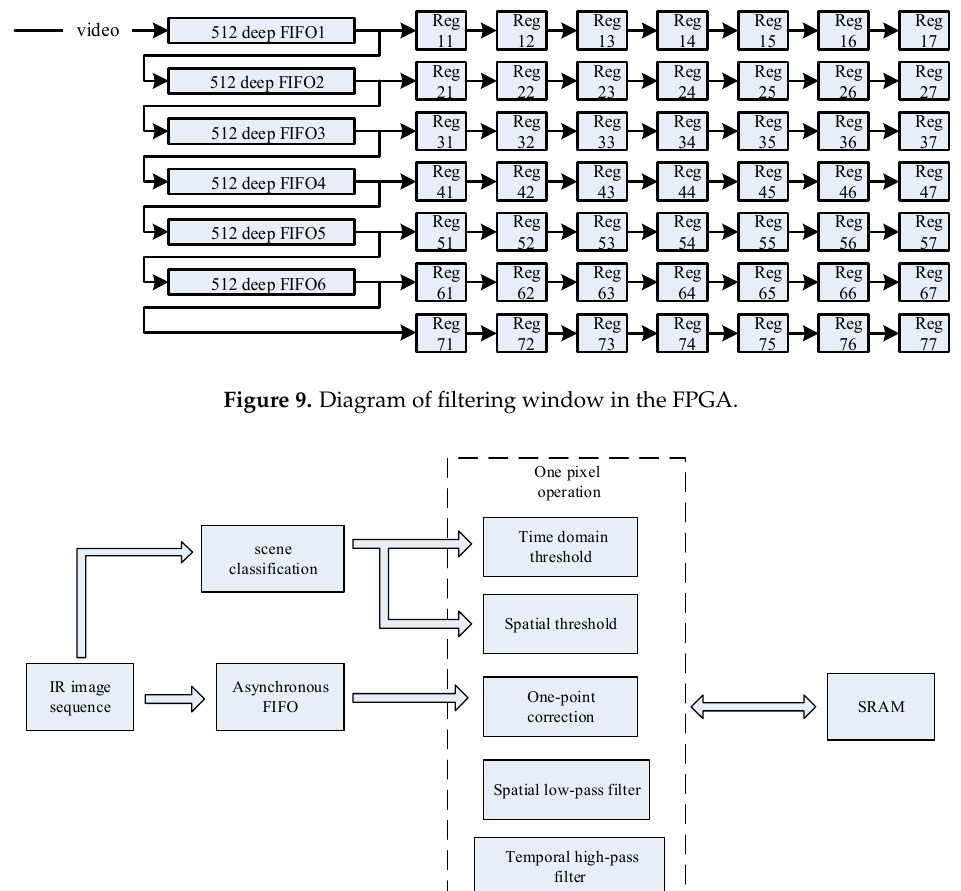
PAL Figure 8. Field-programmable gate array (FPGA) hardware processing system. The algorithm implementation has been conducted in the Verilog hardware description language. It mainly includes adaptive threshold calculation and nonuniformity correction. The calculation of the adaptive threshold is concentrated in the scene classification. The operation of the nonuniformity correction module on one pixel includes reading the same position pixel value of the previous frame, spatial filtering, storing the current frame offset matrix, reading the previous frame offset matrix, modifying the correction matrix, and one point correction, whereas the real-time read and write is done with an external SRAM. The key step is the spatial filtering and the scene classification. The spatial filter mask is generated by the FIFOs in cooperation with the registers. The depth of each FIFO should not be less than the column of the image and the read width is always 16 bits for the infrared imager. As shown in Figure 9, for a 7 × 7 window, six FIFOs are used to connect to each other and cascade with seven sets of Regs (registers). In this way, the data in the FIFOs and Regs are shifted backwards with each pixel clock, which is like a filter mask that automatically swipes to the right pixel by pixel. The 7 × 7 Regs are the filter mask and the data in Reg44 is the center pixel of the